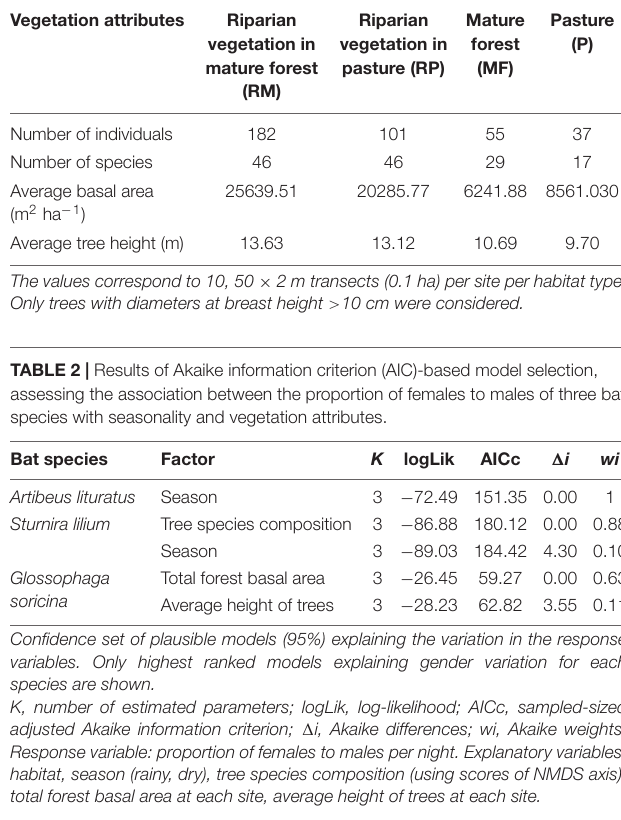
TABLE 1 | Tree community attributes in four different tropical habitat types replicated three times, Chiapas, Mexico. Vegetation attributes